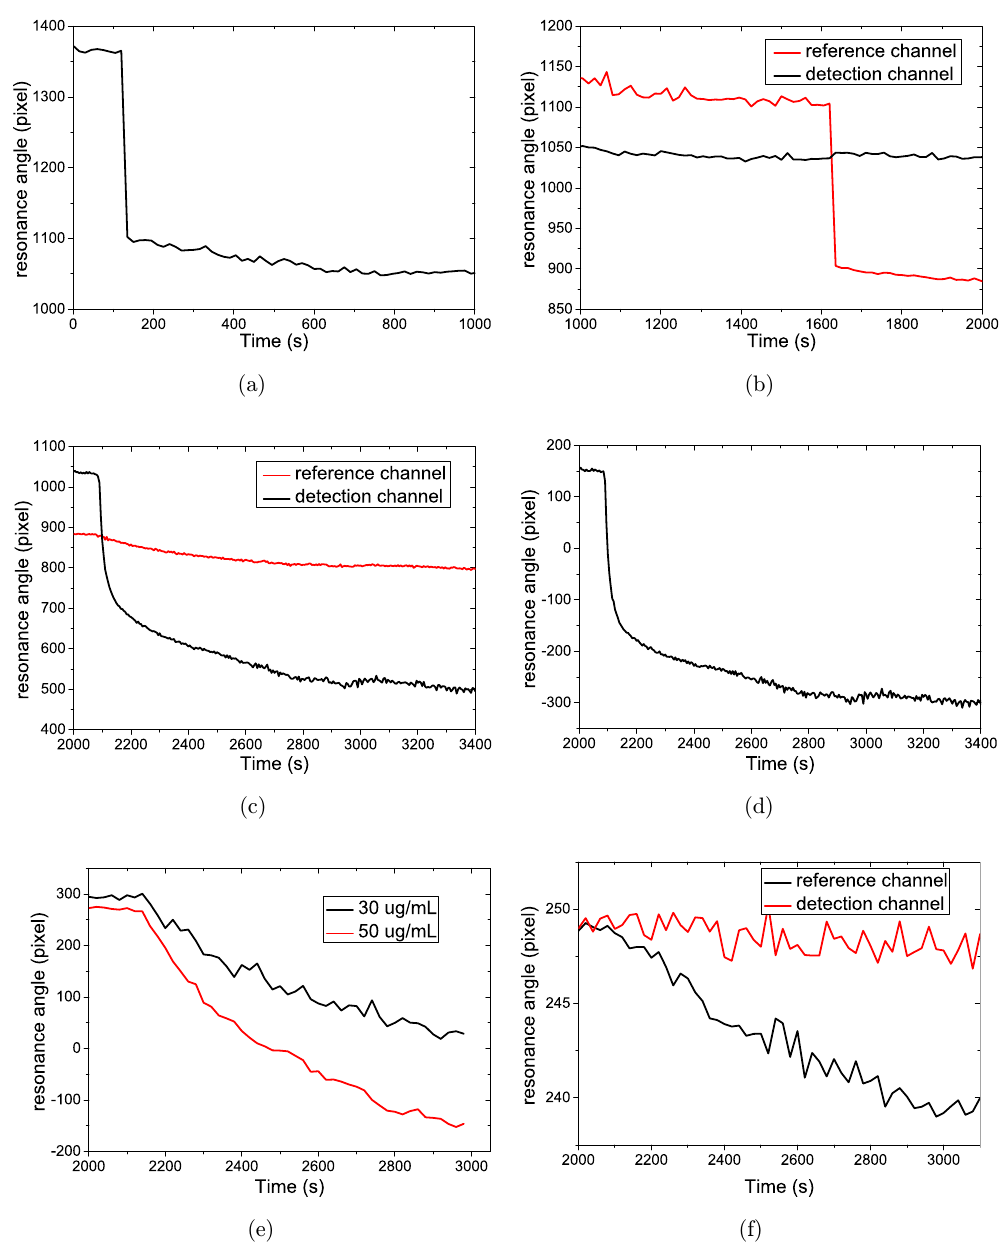
Fig. 6. (a) The measured resonance angle plotted against time in the detection channel pumping the protein A solution into the detection channel. (b) The measurement resonance angles plotted against time when the PBS BSA bu®er is circulated in both channels. (c) The measurement resonance angles plotted against time in both channels monitoring the speci¯c absorption between immobilized protein A probe and IgG in the bu®er. (d) The referenced measurement resonance angles plotted against time monitoring the speci¯c absorption between immobilized protein A probe and IgG in the bu®er. (e) The referenced measurement resonance angles plotted against time measuring 30 (cid:1) g/mL and 50 (cid:1) g/mL IgG solutions. (f) The measurement resonance angles plotted against time in both channels measuring 1 (cid:1) g/mL IgG